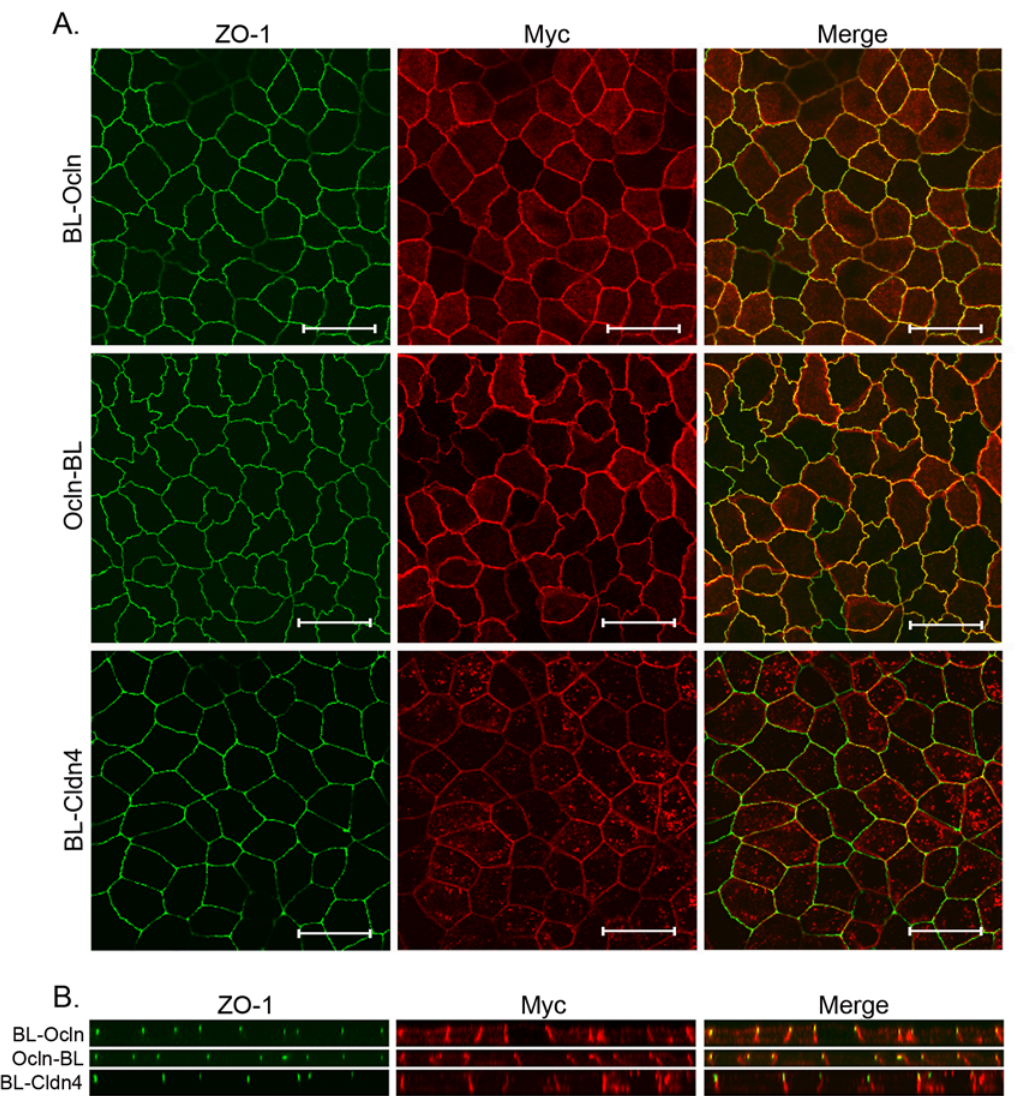
Fig 1. Ocln and Cldn4 biotin ligase fusion-proteins localize to the TJ and the lateral cell membrane. A . Both biotin ligase fused to the N terminus (BL- Ocln, myc) and C terminus (Ocln-BL, myc) of Ocln co-localized ( Merge , top right , middle right panel ) with ZO-1 ( top left and middle left panel ), although there is also some non-junctional immunofluorescence associated with the transgene. Biotin ligase fused to the N terminus of Cldn4 (BL-Cldn4, myc) partly co- localizes with ZO-1 (Merge, bottom right panel), and partly in the cytoplasm (Bottom middle panel). B . BL-Ocln, Ocln-BL and BL-Cldn4 (Myc signal middle panel) are distributed along the basolateral membrane. The two Ocln constructs also concentrate at the apical junction with ZO-1 (right top and middle panel). Bar, 20